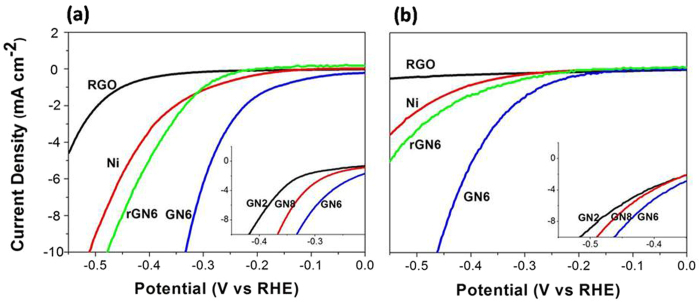
Linear sweep voltammetry (LSV) curves of RGO, Ni, rGN6 and GN6 in 0.50 M H2SO4
solution (a) and in 0.50 M Na2SO4 solution of pH 10 (b). The insets are LSV curves of GN2, GN6, and GN8 composites.